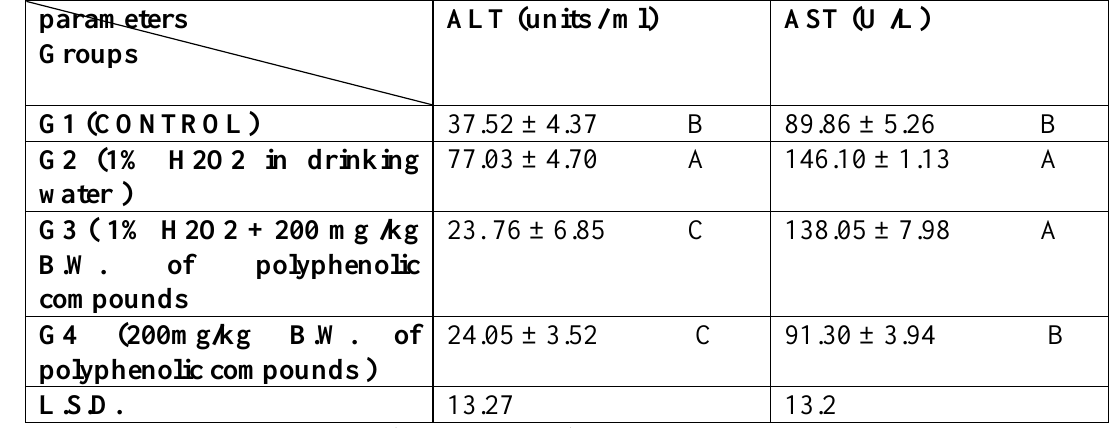
Table (1):- Effect of H2O2 and polyphenolic compounds with H2O2 on Alanine aminotranseferase (ALT) activity units /ml and on Aspartate aminotransferase (AST) activity U/L in adult males